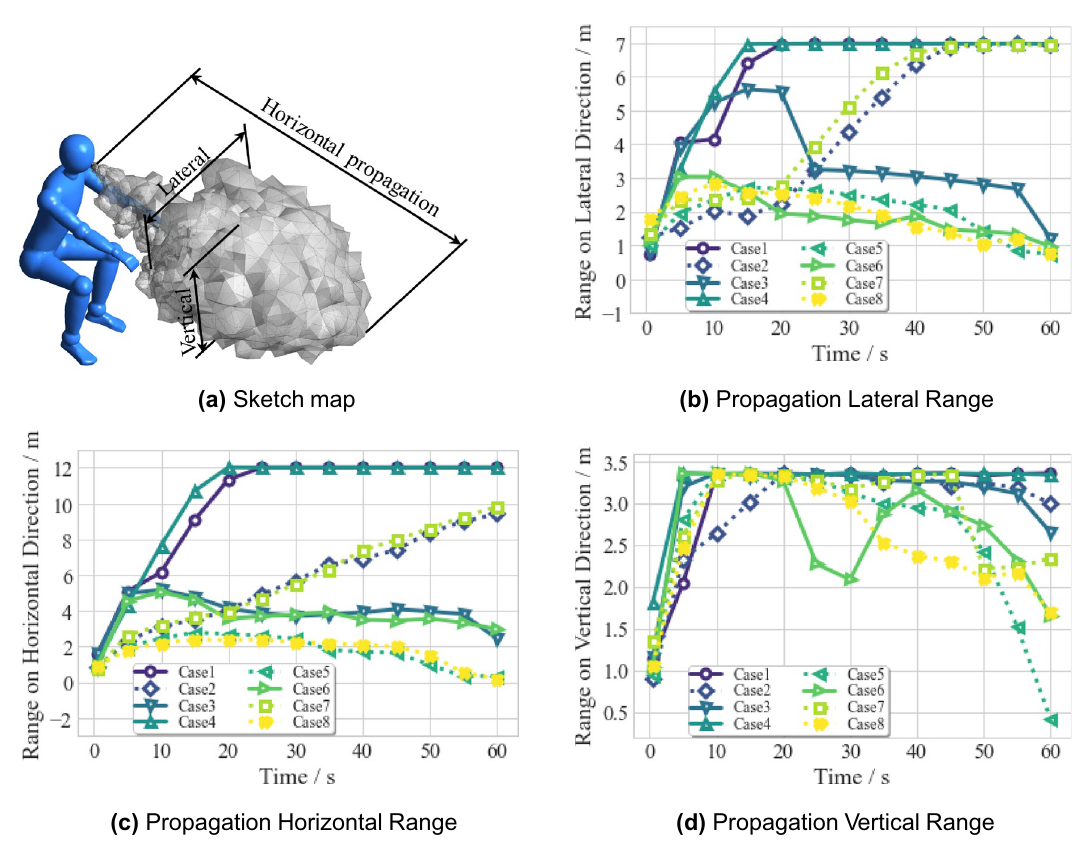
Figure 25. Propagation range of droplet cloud varies with time. ( a ) Drawn in Tecplot 360 (version 2016 R2) and Adobe Illustrator (version